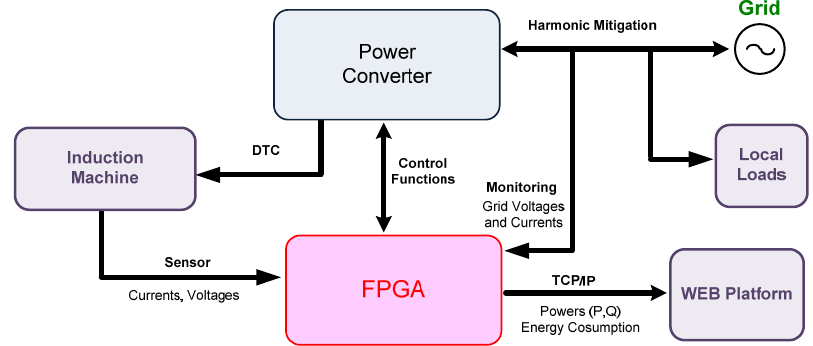
Figure 1. Multifunctional device overall diagram.